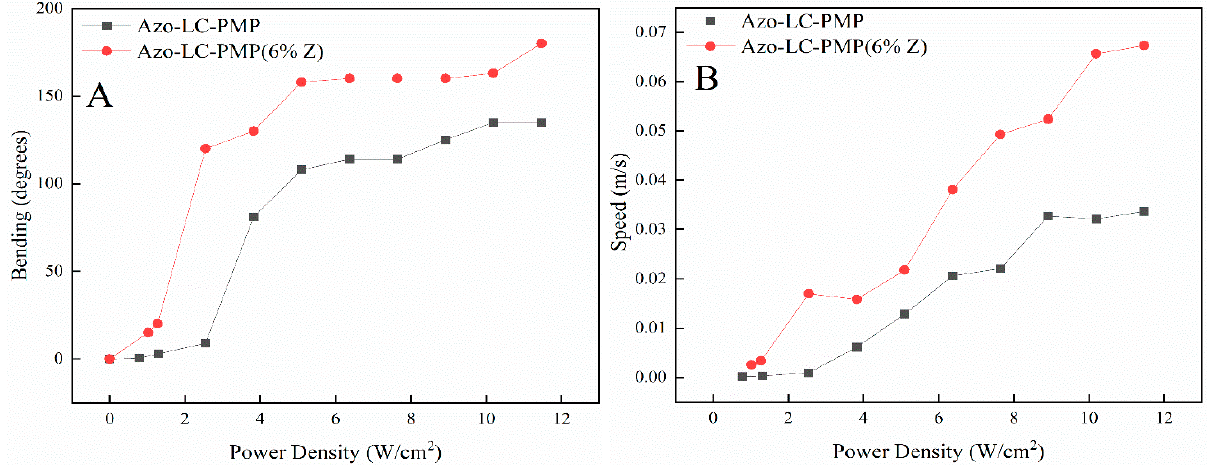
Figure 10. Comparison between the maximum bending ( A ) and speed ( B ) of Azo-LC-PMP and ZnO doped AZO-LC-PMP films. The graphs show the increased efficiency of the doped PMPs in terms of bending and speed.